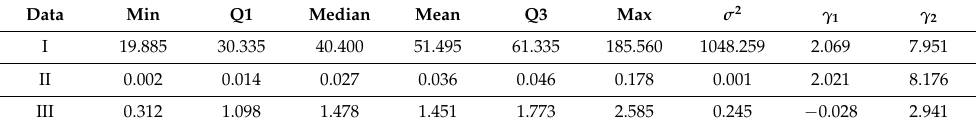
Table 15. Data summarized.